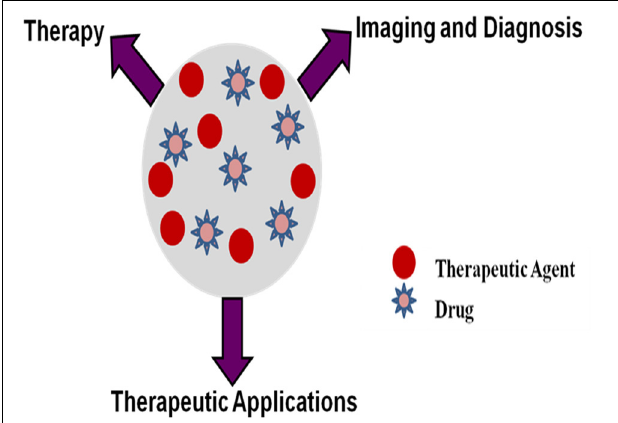
FIGURE 4 | Theragnostic